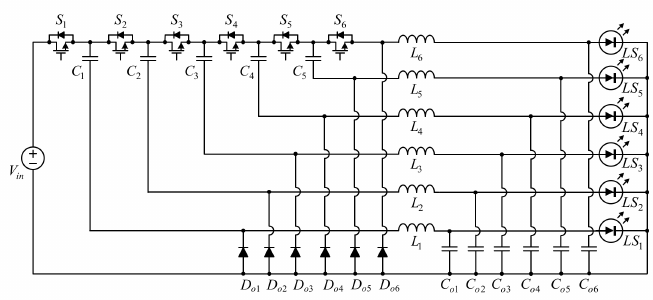
Figure 10. Six-phase LED